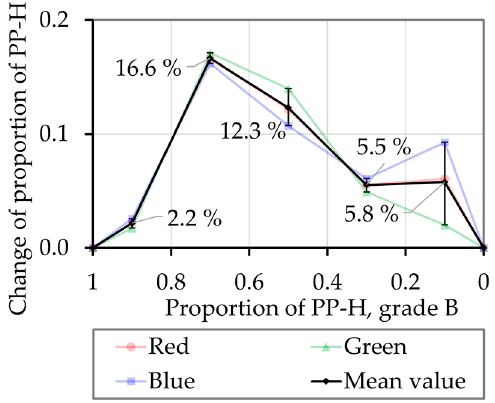
Figure 19. Corrected values of the change of the melted proportion of material ∆ ξ Mat for the mixture Figure 19 . Corrected values of the change of the melted proportion of material 𝛥𝜉 (cid:3014)(cid:3028)(cid:3047) for the mixture PP-H / HDPE as a function of the proportion of PP-H, grade PP-H/HDPE as a function of the proportion of PP-H, grade B.